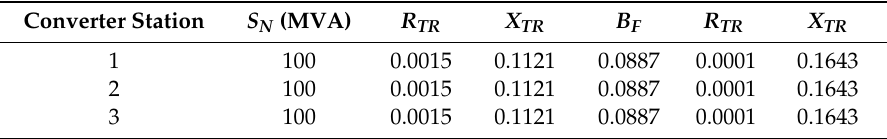
Table 3. Parameters of the converter stations in